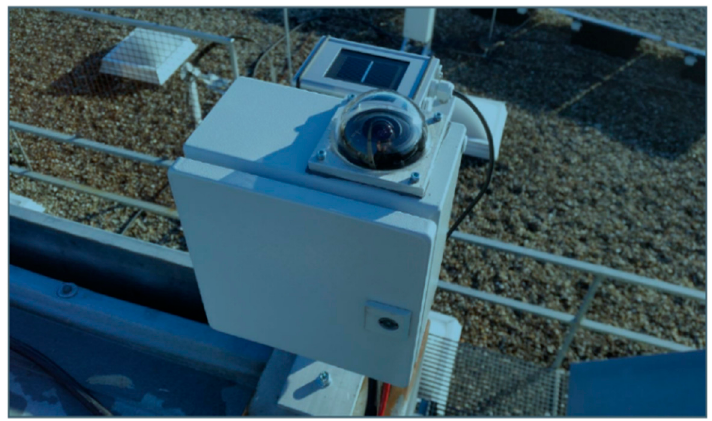
Figure 1. The ground-based camera sensor system positioned at Offenburg University.